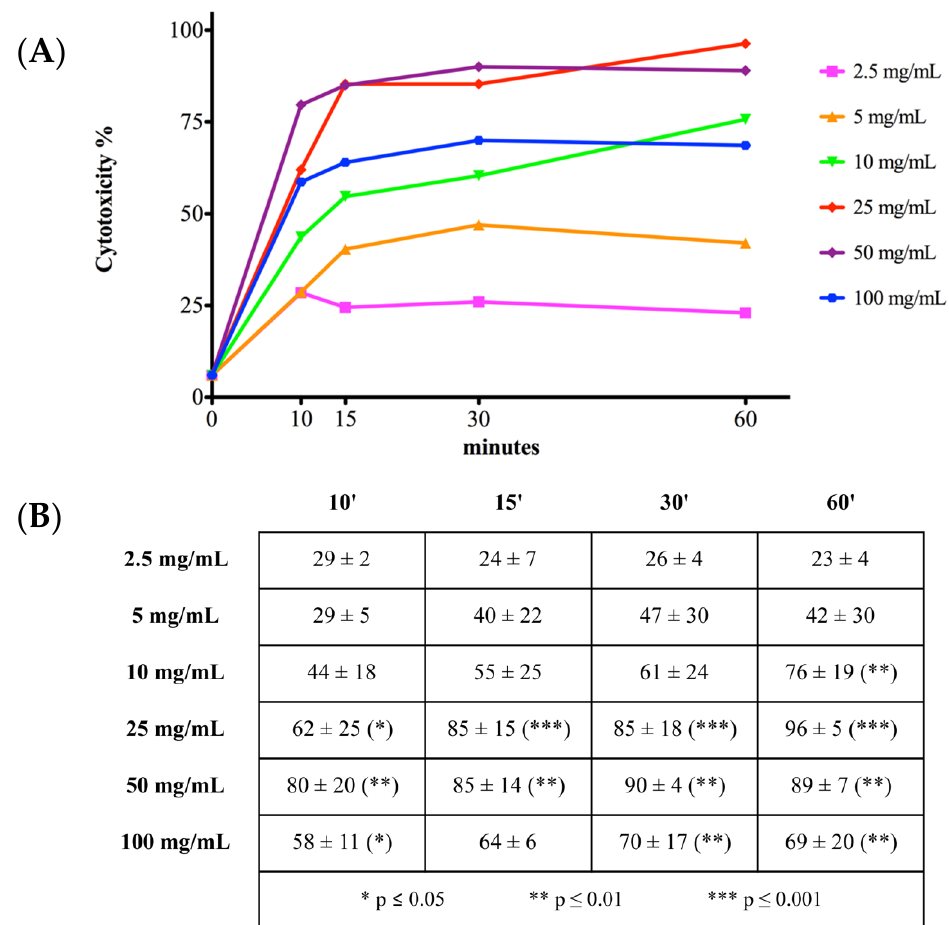
Figure 3. Cytotoxicity dose–time curves. ( A ) Each point corresponds to a vancomycin treatment at a different concentration at a certain time point. Relative cytotoxicity was calculated considering cells treated with MeOH for 30 ′ as a baseline of 100%. ( B ) Cytotoxicity results were expressed as mean percentage ± standard deviation for at least three independent experiments. Cytotoxicity was significantly increased by 10 mg/mL vancomycin at 60 min as well as by 25 mg/mL, 50 mg/mL, and 100 mg/mL approximately at all timepoints. Statistical significance was calculated versus the control group (0 mg/mL vancomycin) and reported as * p ≤ 0.05, ** p ≤ 0.01 and *** p ≤ 0.001. See text for details.